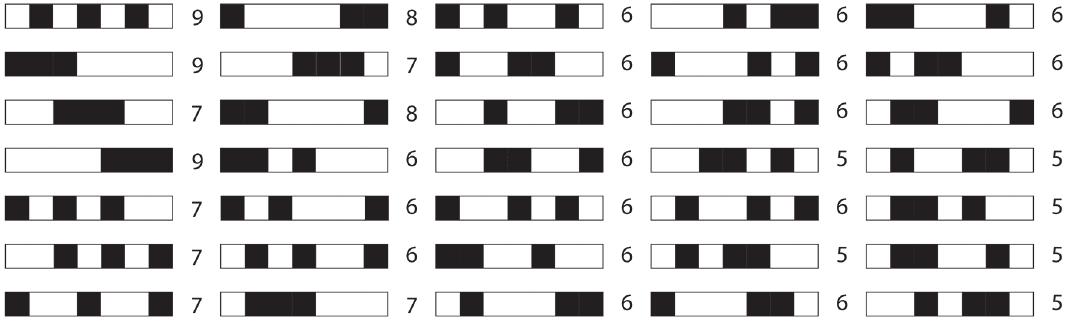
Figure 8. Symmetry strips sorted by perceived coherence. Source: { Foreshadowing } [22], redrawn by the author R.P.G.